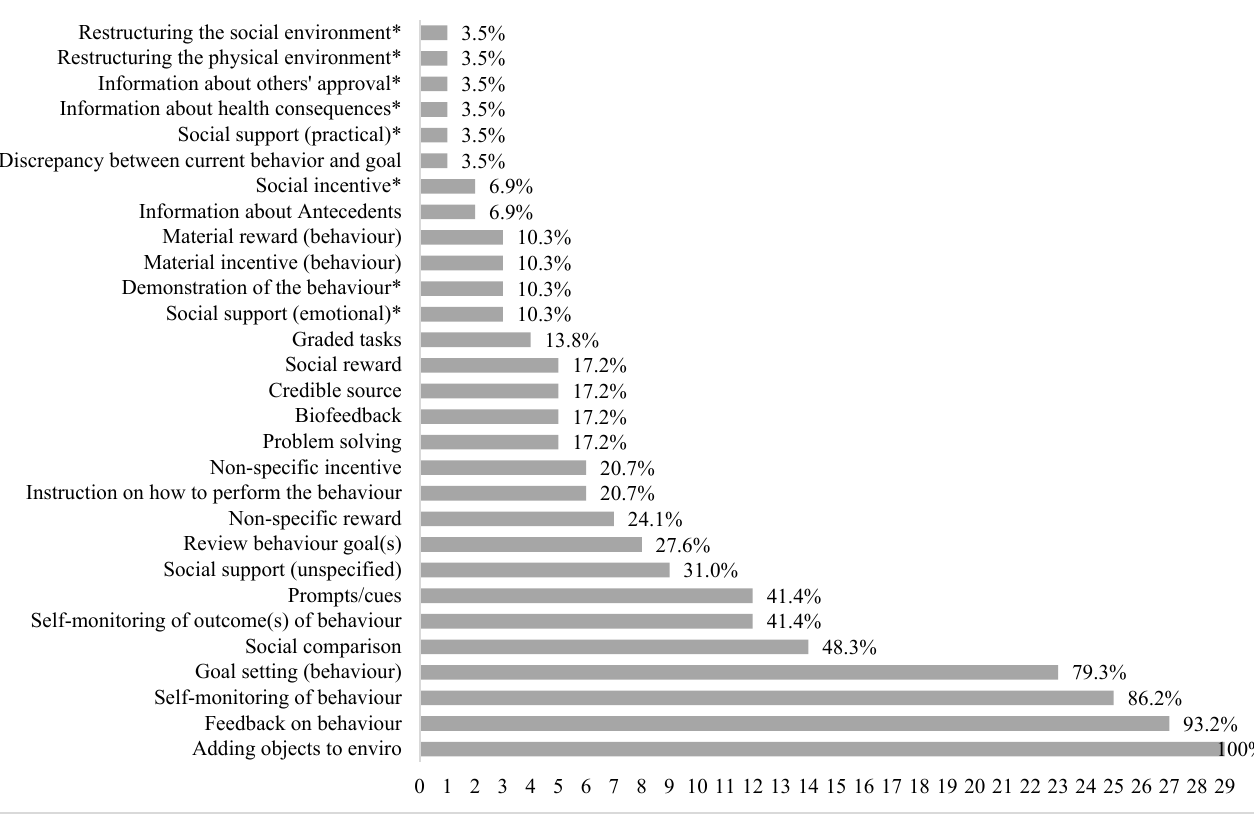
Figure 3. Total number of wearable groups with BCTs present in studies investigating effectiveness ( n = 29). * Present in multi-component study groups exclusively.